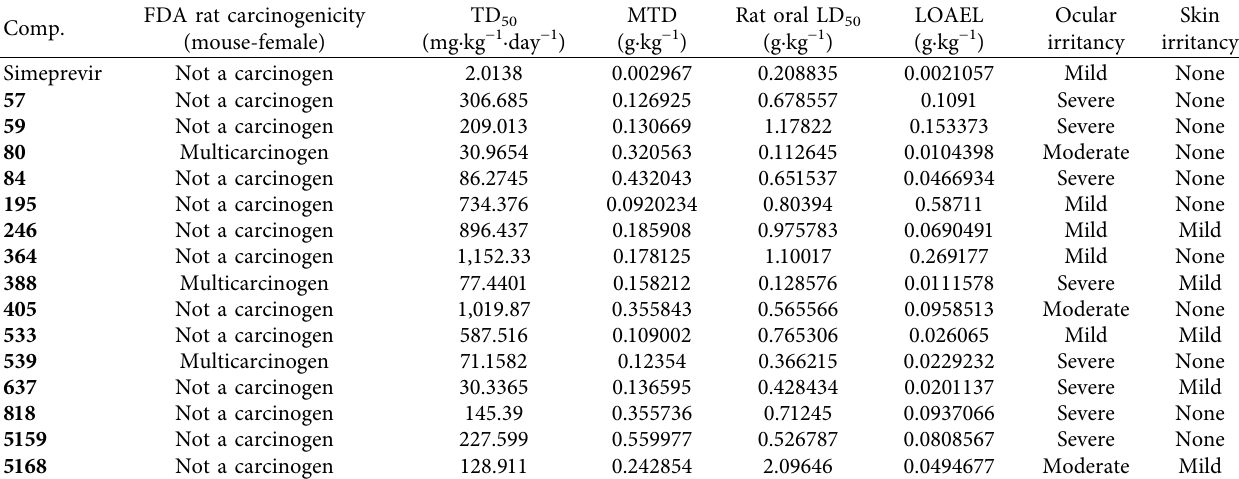
Table 5: In silico toxicity profile of 15 compounds with good ADMET profile.